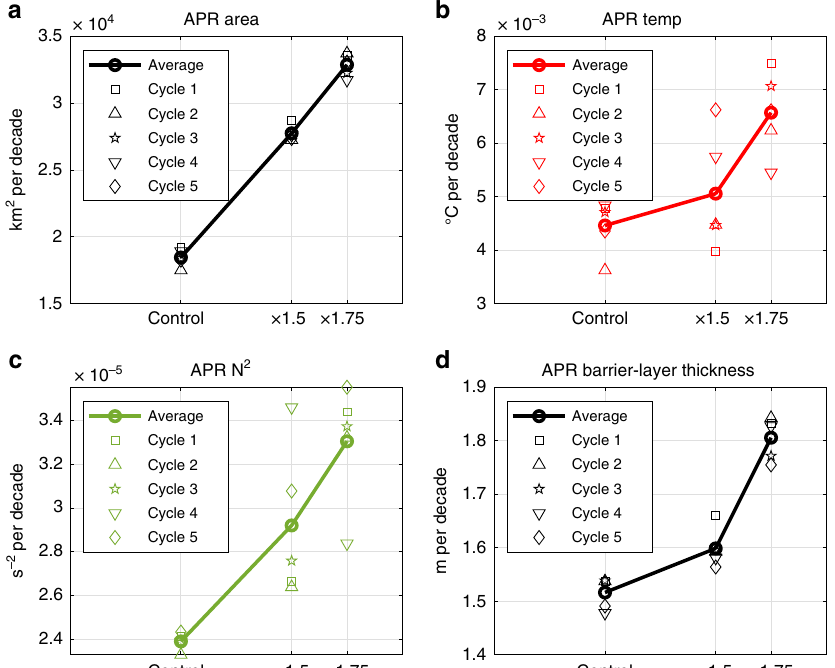
Fig. 5 Sensitivity of the trends in Amazon plume region (APR) size, ocean temperature, buoyancy frequency ( N 2 ), and barrier-layer thickness in response to seasonality changes in Amazon river runoff forcings in ocean model experiments. a Seasonality changes in the size of APR, de fi ned as the region where 5-m ocean salinity is <34.5 PSU. b Seasonality changes in the 5-m ocean temperature averaged over the region where 5-m ocean salinity is <34.5 PSU. c , d similar to b , but for seasonality changes in buoyancy frequency and barrier-layer